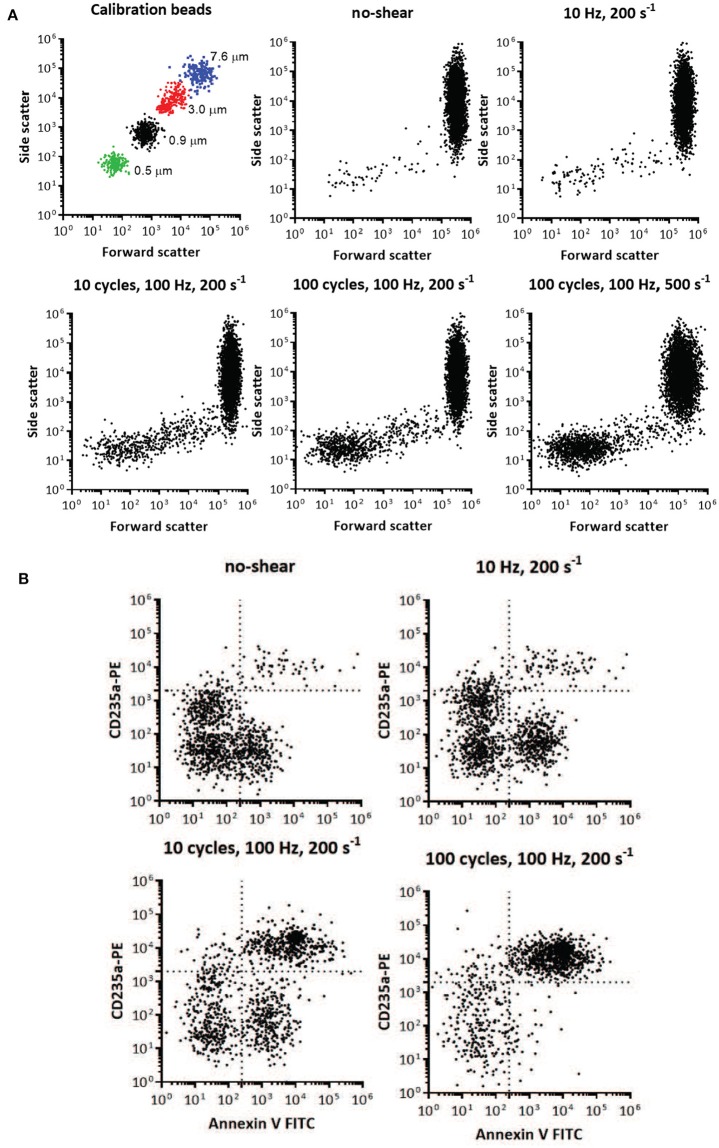
Flow cytometry identification of presence and size of RBC vesicles based on the light scatter parameters and quantification of RBC vesicles based on marker for phospholipid PS and glycophorin A (CD235A) using flow cytometry. (A) Light scatter results using side scatter (SSC) as the indicator of shape and forward scatter (FSC) the indicator of size. Top left panel shows light scatter parameters of the mixture of standard calibration beads (7.6, 3, 0.9, and 0.5 μm). Other panels show light scatter parameters of the blood samples before mechanical shear (no-shear), and after being subjected to different frequencies, cycles, and degrees of oscillatory shear. Inspection of the scatter from the calibrated beads and the blood subjected to mechanical shear indicates the increasing presence of vesicles below 1 μm in size. Direct size comparison cannot be made between beads and vesicles, since beads have a higher index of refraction, and therefore lower size threshold, than vesicles (Lacroix et al., 2010; Yuana et al., 2011). (B) Flow cytometry analysis of RBC vesicles extracted from blood before oscillatory shear (no-shear), and after being subjected to different frequencies and number of cycles of oscillatory shear. Only events positive to anti-CD235a and Annexin V were defined as RBC vesicles (Kriebardis et al., 2008). The number of calibration beads was counted to determine the absolute number of RBC vesicles. The number of cells was approximately 107.